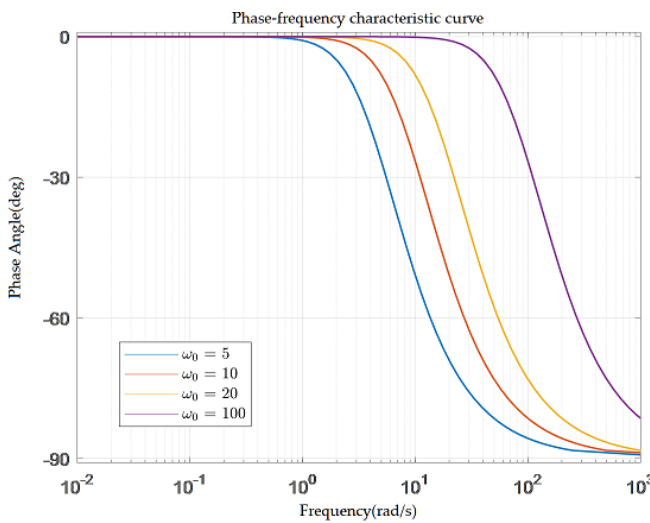
Figure 13. Measurementof noise phase